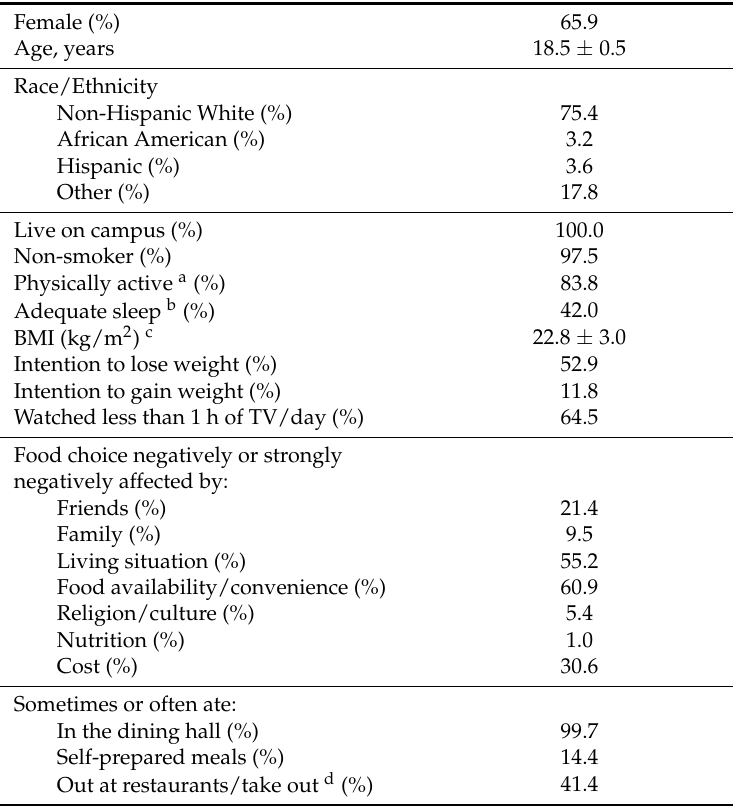
Table 1. Overall sample characteristics of Freshman participants ( n = 630).